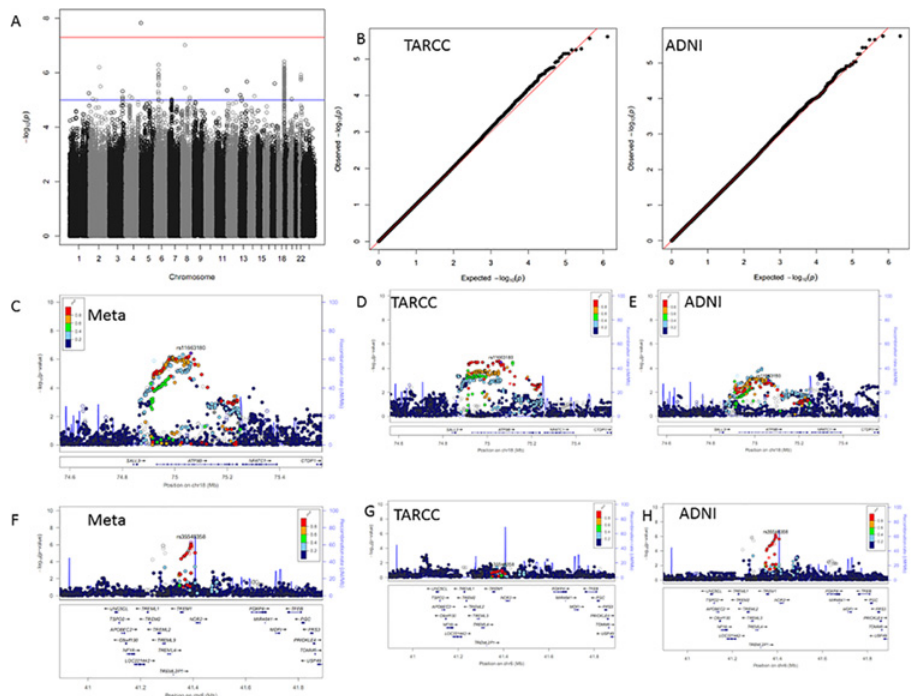
Fig 3. MCP1 results. Panel A; GWAS Manhattan plot for meta-analysis of MCP1. Panel B; QQ plots for the association results for TARCC (left) and ADNI (right). Panel C; LocusZoom plot for the chromosome 18 signal from the meta-analysis. Panels D and E; LocusZoom plots for the chromosome 18 signal in TARCC and ADNI, respectively. Panel F; LocusZoom plot for the chromosome 6 signal from the meta-analysis. Panels G and H; LocusZoom plots for the chromosome 6 signal in TARCC and ADNI,